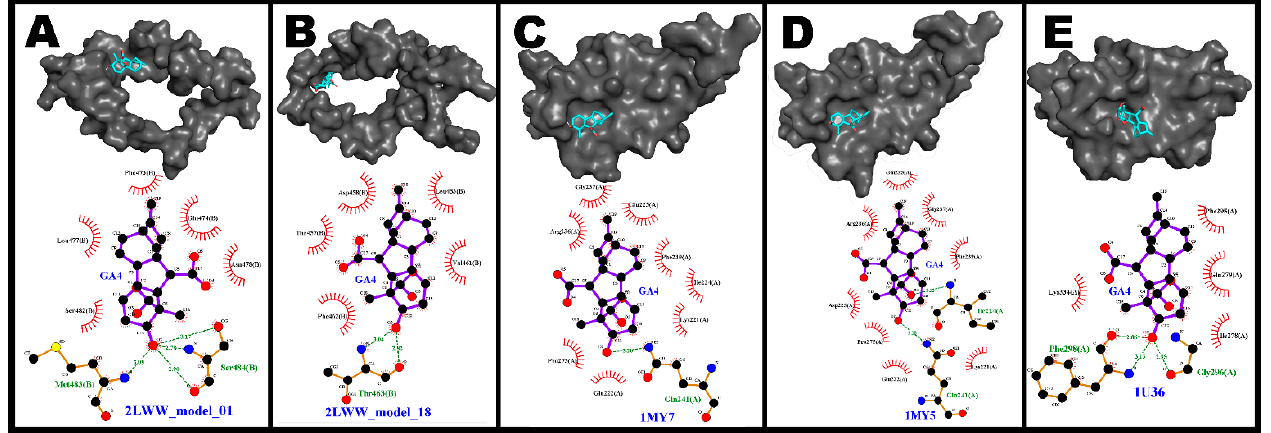
Figure 3. 3D and 2D diagrams of the binding between the plant hormone gibberellin A4 (GA4) and the proteins 2LWW_model_01 ( A ), 2LWW_model_18 ( B ), 1MY7 ( C ), 1MY5 ( D ), and 1U36 ( E ).